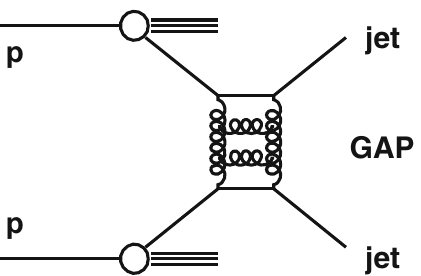
Fig. 1 Schematic diagram of a dijet event with a rapidity gap between the jets (jet-gap-jet event). The gap is defined as the absence of charged particle tracks above a certain p T threshold